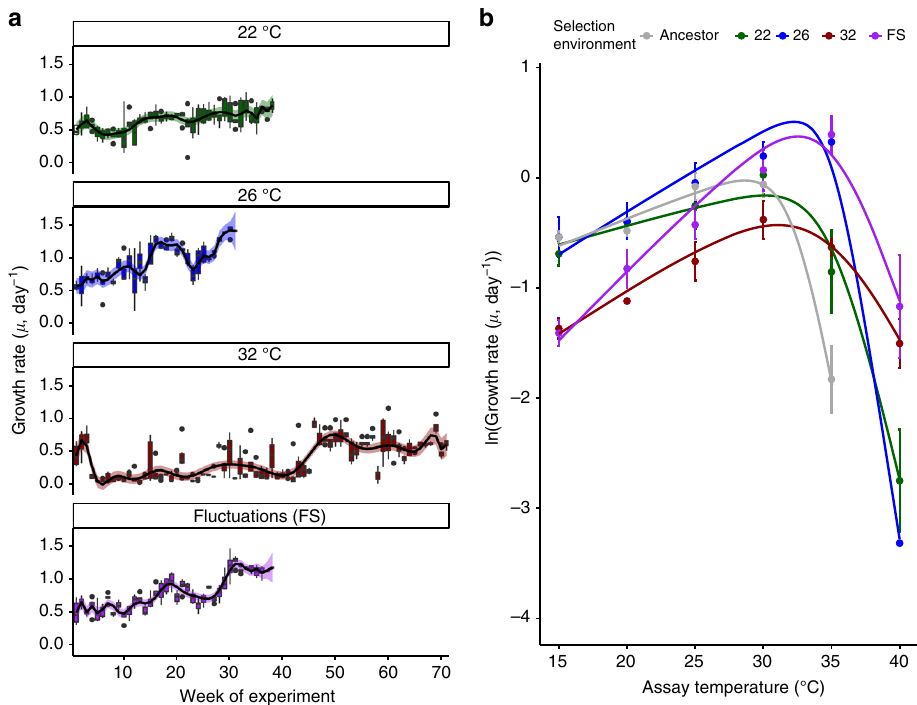
Fig. 1 Growth rate trajectories and rapid evolutionary shifts in thermal tolerance curves. a Time-series of population growth rates reveal immediate and sustained increases in growth rates in populations adapting to moderate warming and the environment that fl uctuated between 22 (benign conditions) and 32 °C (severe conditions). In the 32 °C environment populations performed very poorly for approximately 1 year (~100 generation), followed by an evolutionary rescue event, which caused growth rates to increase to levels comparable with the control treatment at 22 °C. Boxplots were created by binning growth rate estimates across replicates on each week of the experiment until 300 generations had passed in each lineage. Fitted lines are from the best fi ts of a GAMM (see Methods and Supplementary Table 2), with shaded areas indicating 1 s.e.m. and boxplots are displayed so that whiskers indicate 1.5 × interquartile range. b Thermal response curves of the ancestor and evolved lineages show marked shifts in thermal tolerance. Populations selected under moderate, severe, and fl uctuating warming all evolved increased tolerance of high temperatures relative to the ancestors and the control. Values are means and error bars denote ± 1 s.e.m. Fitted lines are the fi xed effects of a nonlinear mixed effects model. Gray curves denote the ancestor, green, samples are the control at 22 °C, blue at 26 °C, red at 32 °C, and purple is the fl uctuating however, lower than those for R ( T opt for P : 27 °C ± 0.7 °C, (±s.e.